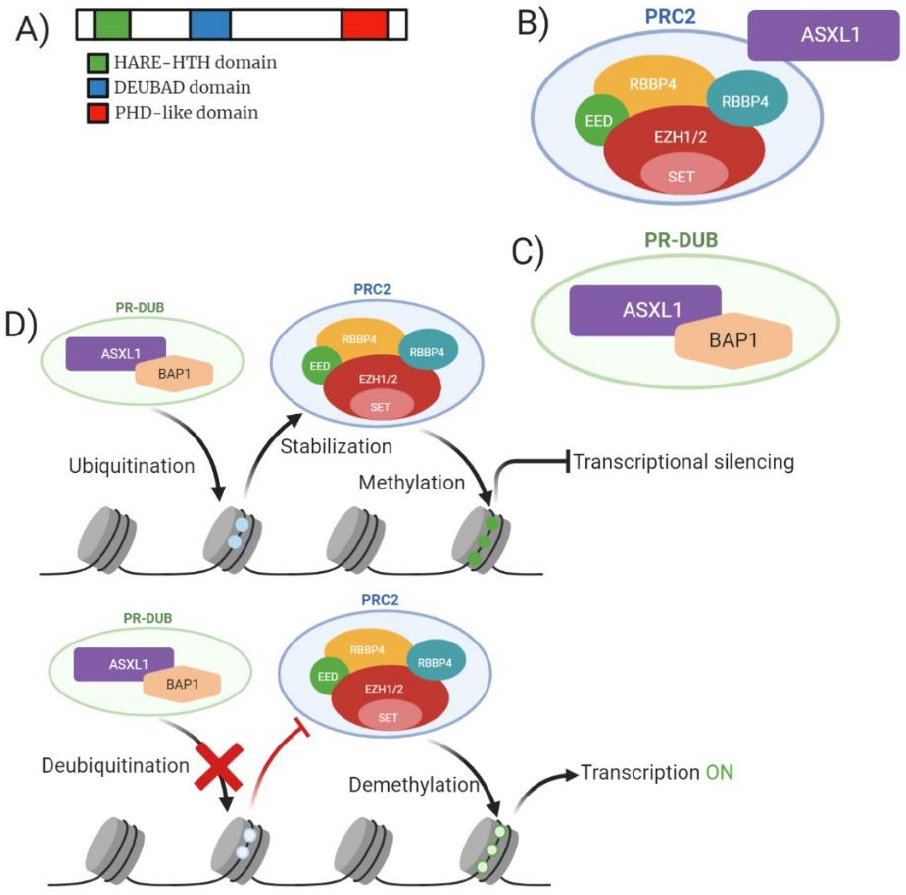
Figure 6. Analysis of ASXL1 molecular structure, ASXL1/PRC2 structure, PR-DUB structure, and mechanism of action for wild-type and mutant ASXL1 . ( A ) Domain structure of mammalian ASXL1 enzyme consisting of 1541 amino acid residues. Green highlighting HARE-HTH (HB1, ASXL1 restriction endonuclease helix-turn-helix). Yellow highlighting DEUBAD (deubiquitinase adaptor). Blue highlighting c terminal PHD domain. ( B ) Model of mammalian PRC2 complex with core subunits and association with ASXL1 . ( C ) Model of PR-DUB complex with BAP1 and ASXL1 . ( D ) Mechanism of action for both wild-type and mutant ASXL1 in relation to function with PRC2. Wild- type ASXL1 contributes to ubiquitination of H2AK119 enabling stabilization of PRC2 leading to trimethylation of H3K27 resulting in transcriptional silencing. Mutant ASXL1 causes deubiquitylation of H2SK119 preventing the stabilization of PRC2 resulting in reduced methylation of H3K27 resulting in increased gene